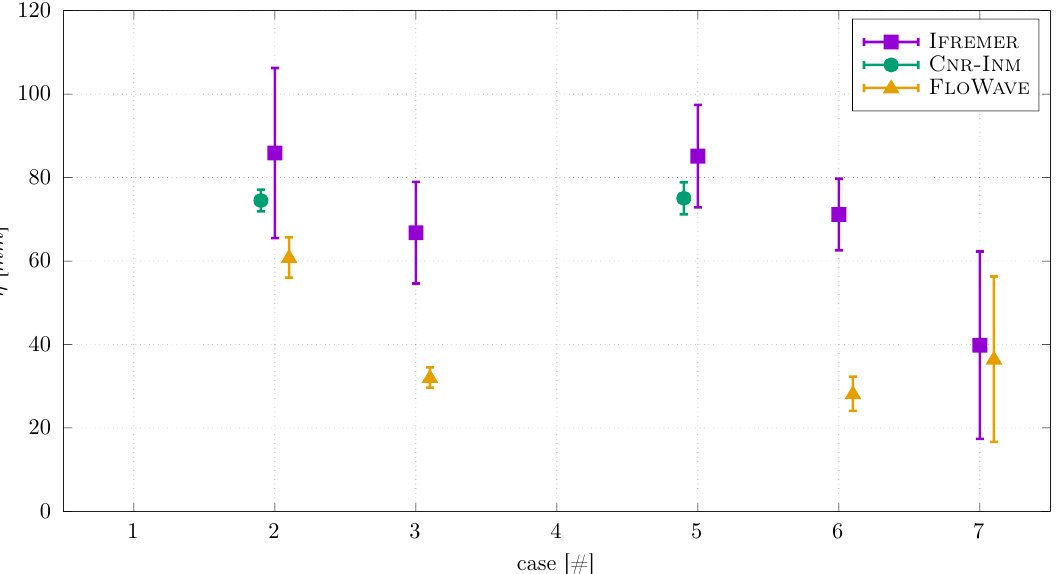
Figure 13. Average and standard-deviation of the amplitude of the Hilbert transform of the surface elevation η , at the turbine location, versus the case number (see Table